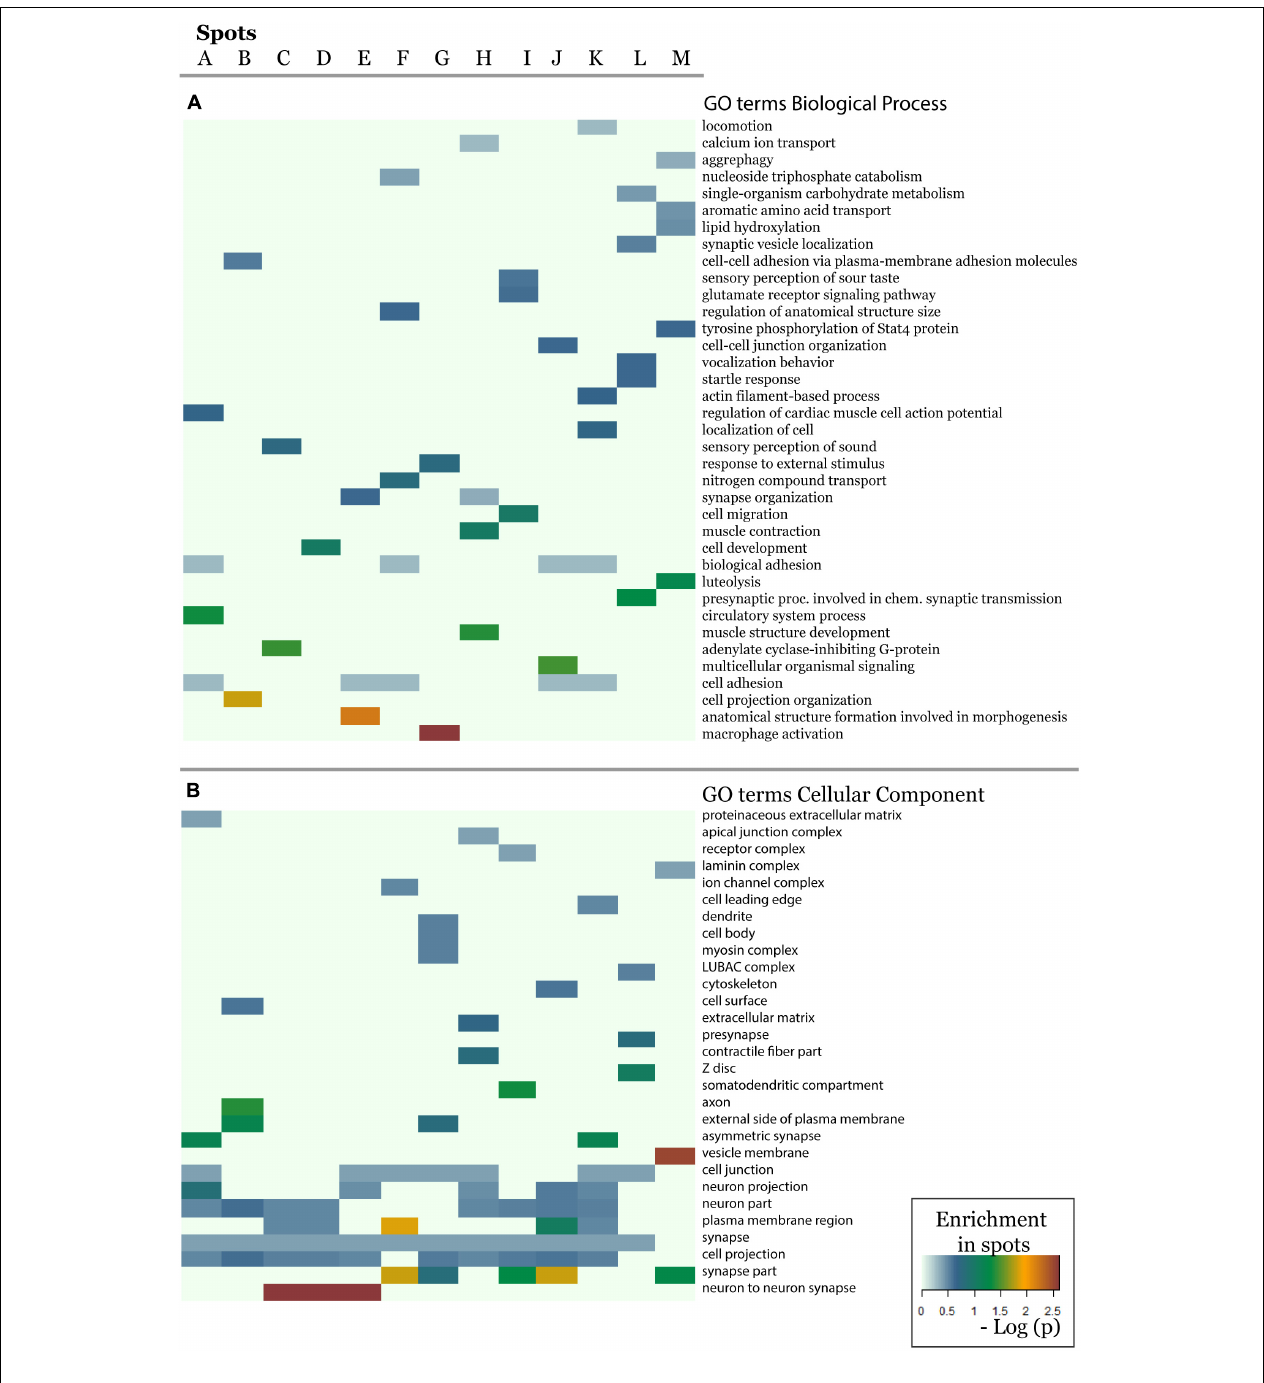
FIGURE 5 | The biological context of the spots is estimated by means of enrichment analysis using the GO terms (A) biological process and (B) cellular component. Enrichment p -values (Fisher’s exact test) were visualized as heatmap. One sees that, e.g., GO-terms related to neuronal function are enriched in most of spots but especially in spots showing minor allele preference in